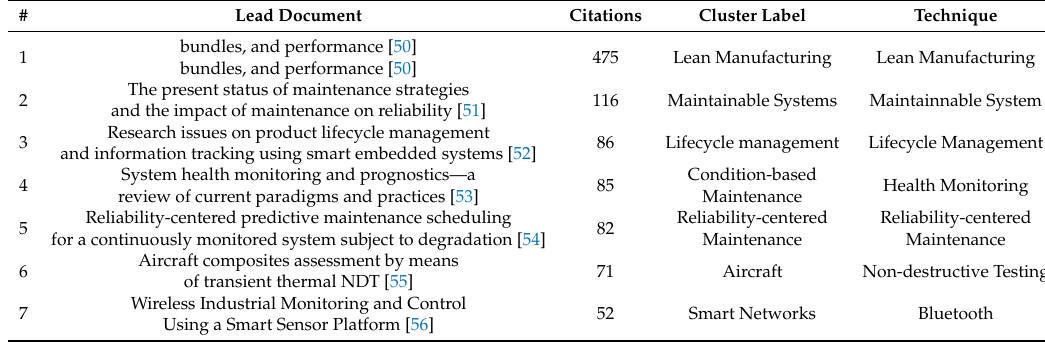
Table 6. Research Front